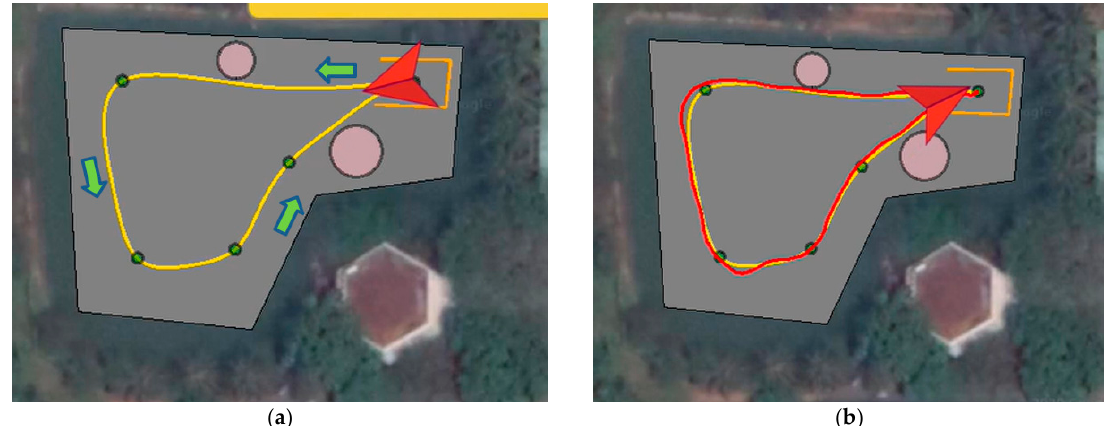
Figure 14. Planned B-Spline path by path planner in GCS in ( a ); traveled path in ( b ).